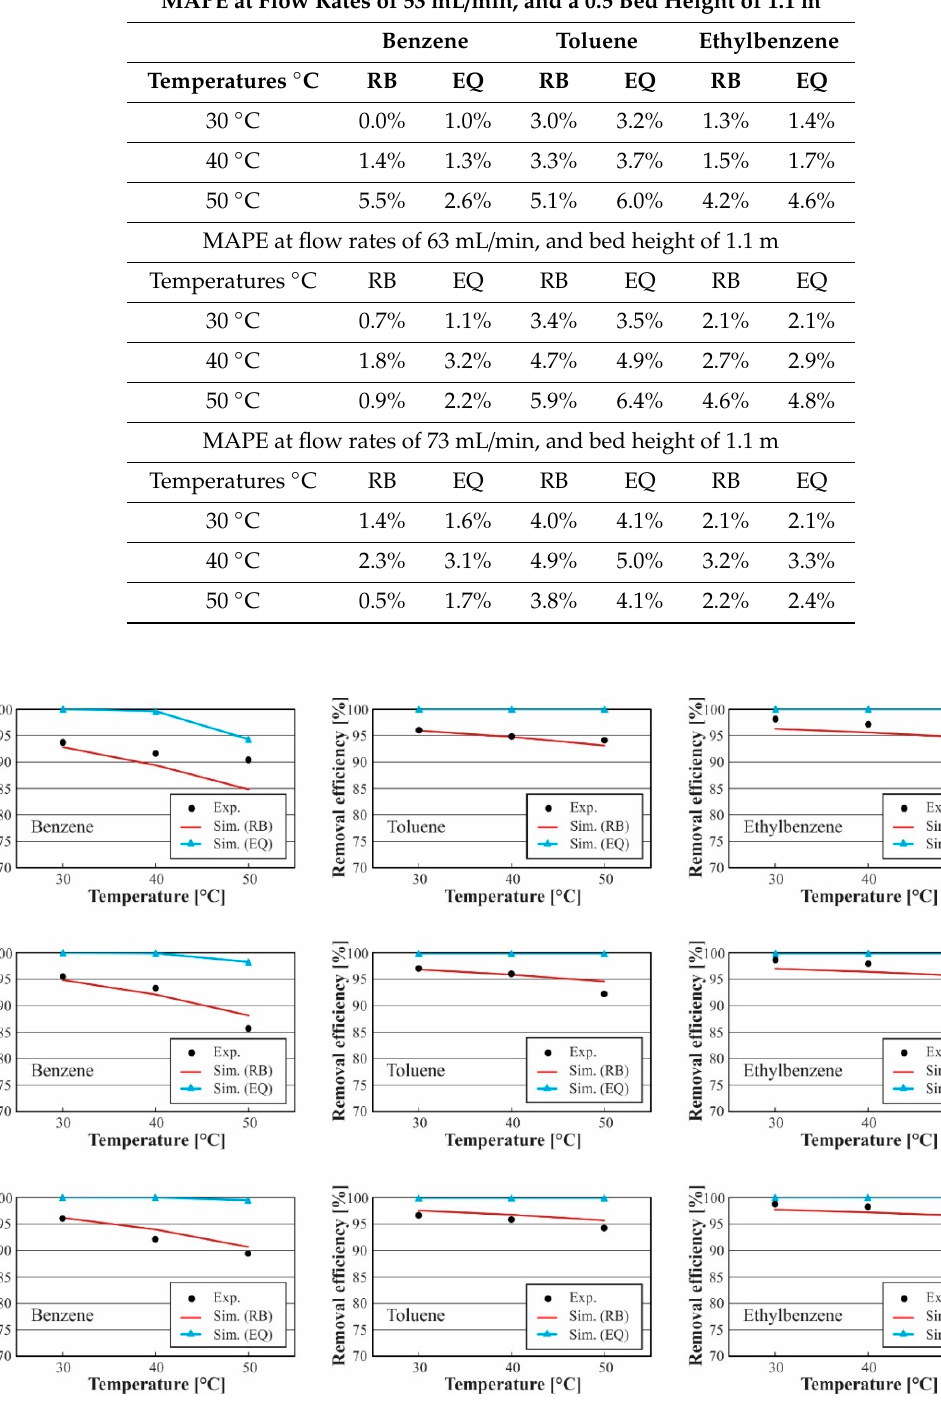
Figure 7. Effect of solvent temperature on the removal efficiency of tar components at a bed height of Figure 7. E ff ect of solvent temperature on the removal e ffi ciency of tar components at a bed height 0.5 m and different solvent volumetric flow rates of 53 mL/min (above), 63 mL/min (middle), 73 of 0.5 m and di ff erent solvent volumetric flow rates of 53 mL / min ( above ), 63 mL / min ( middle ), mL/min (below). 73 mL / min ( below